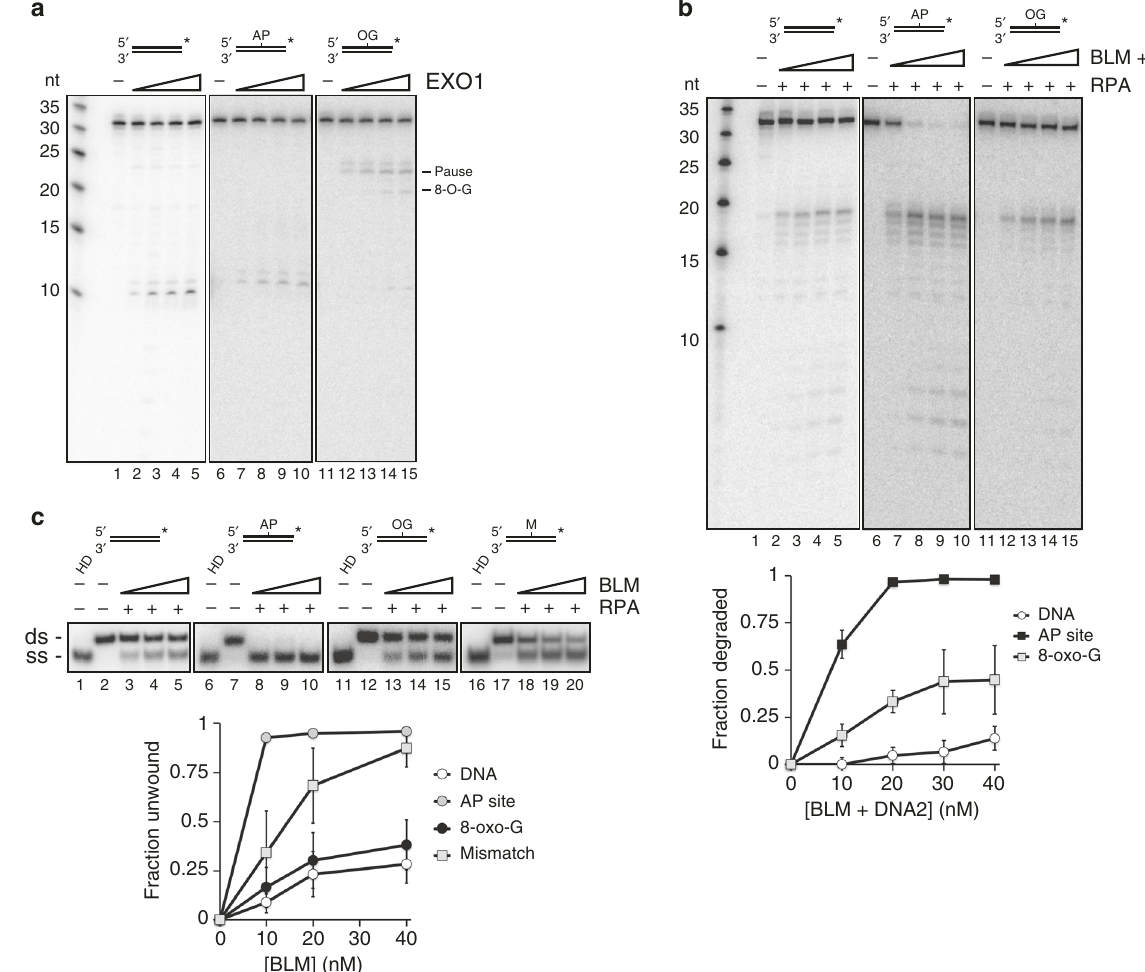
Fig. 5 Effect of 8-oxo-G and AP site on resection by EXO1 and BLM-DNA2. a EXO1 (10, 20, 30, 40 nM) was incubated with the indicated substrate (2.5 nM) at 37 °C for 10 min. The 8-oxo-G and AP site are indicated by OG and AP, respectively. Reaction mixtures were resolved in a 20% denaturing acrylamide gel. b BLM, DNA2 (10, 20, 30, 40 nM) and RPA (12.5 nM) were tested on the same substrates in ( a ). c DNA unwinding by BLM (20, 40, 60 nM) was examined in the presence of RPA (12.5 nM) as in Fig. 3b. Error bars in all the panels represent the standard deviation of results from n = 3 independent experiments, and all points represent the mean. In some cases, the error bars are smaller than the symbol and are thus not easily discernable. RNA is denoted in red, and the asterisk indicates the location of the